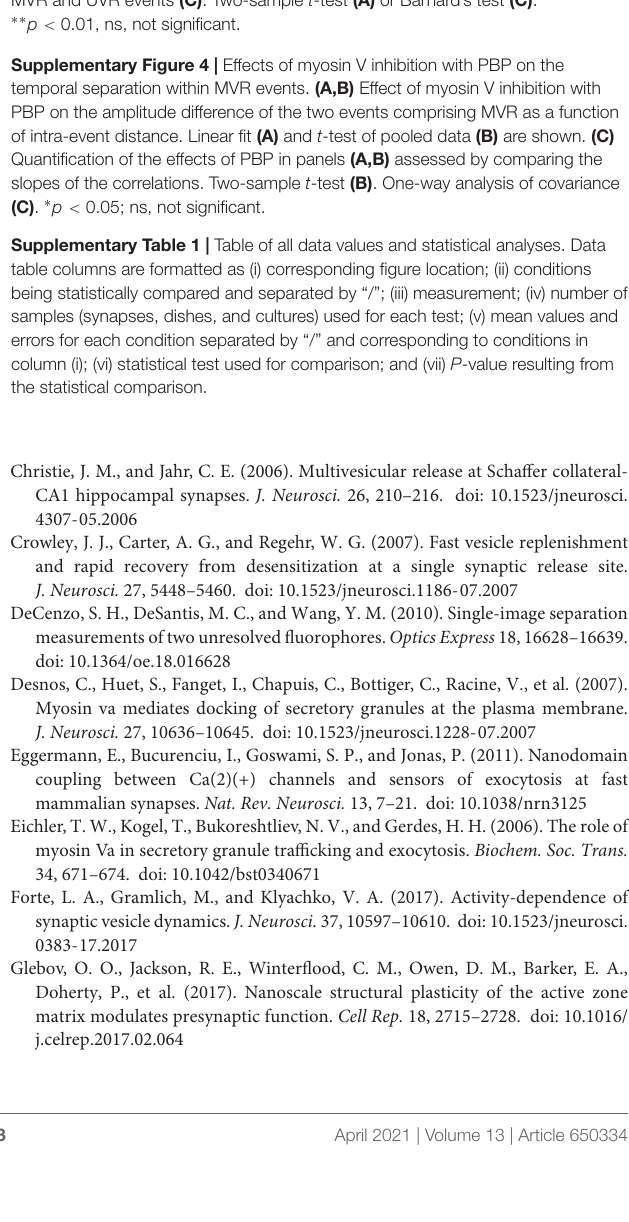
calculated based on a multi-Gaussian fit (C) . (D,E) Effects of myosin V inhibition with PBP on the distance between two fusion events comprising an MVR for resolved events. Cumulative plots (D) and mean values (E) are shown. (F,G) Same as (D,E) for unresolved MVR events. (H,I) Effects of myosin V inhibition with PBP on the distance from MVR events to the AZ center for resolved events. Cumulative plots (H) and mean values (I) are shown. (J,K) Same as (H,I) for unresolved MVR